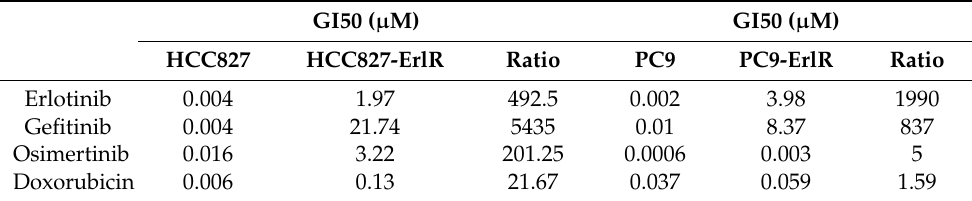
Table 1. The sensitivity of erlotinib-resistant and parental HCC827 and PC9 cells treated with anticancer drugs. GI 50 values of HCC827, HCC827-ErlR, PC9, and PC9-ErlR cells treated with erlotinib, gefitinib, osimertinib, and doxorubicin are shown. GI 50 values were calculated using SigmaPlot